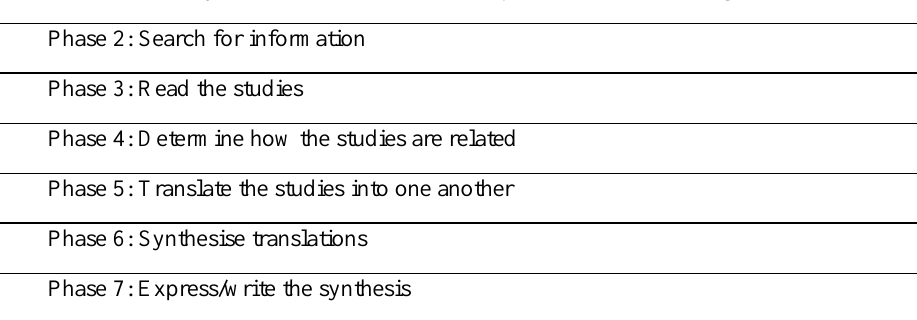
Meta-ethnography's seven phases (Noblit & Hare, 1988) Phase 1: Identify an intellectual interest that qualitative research might inform Phase 2: Search for information Phase 3: Read the